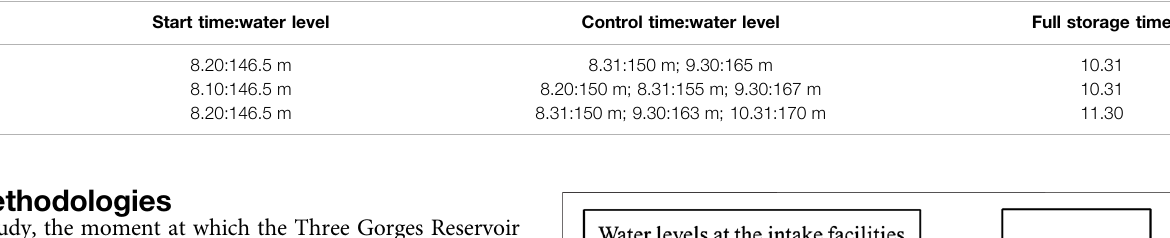
TABLE 3 | Establishment of three impoundment plans for the Three Gorges Reservoir.